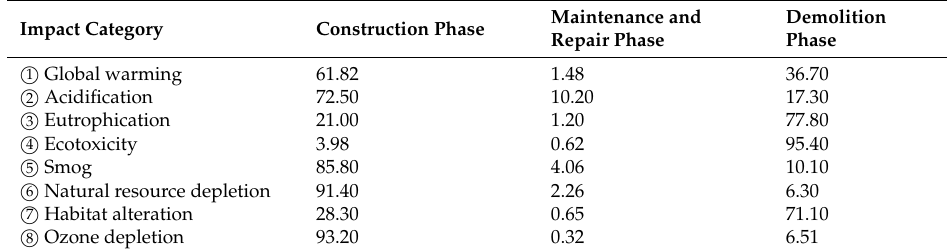
Table 3. The contribution of environmental emissions to environmental impact of fast track transportation project in each life cycle phase